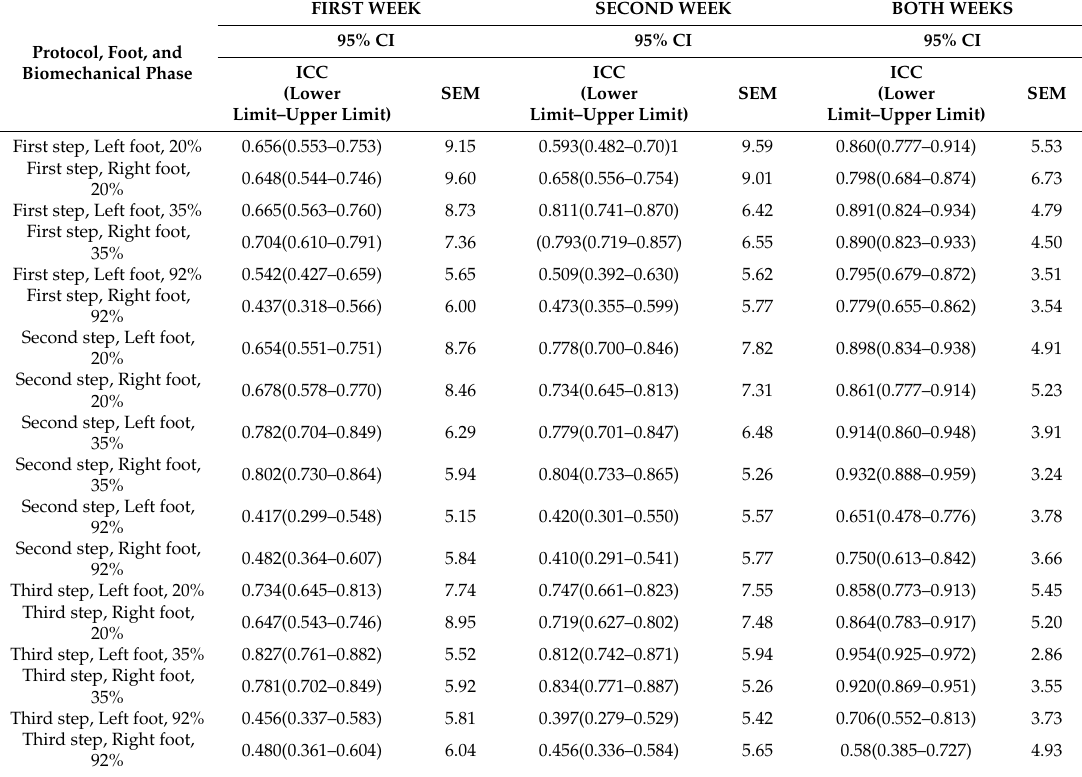
Table 3. Intra-class correlation coe ffi cient (ICC) and standard errors of the mean (SEM) for Contact Surface Areas,